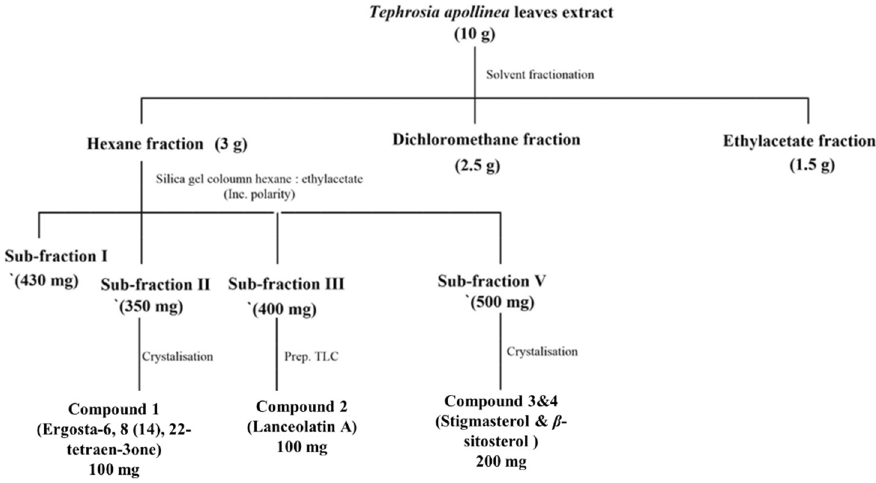
Figure 12. Schematic diagram of the phytochemical isolation of compounds 1–4.